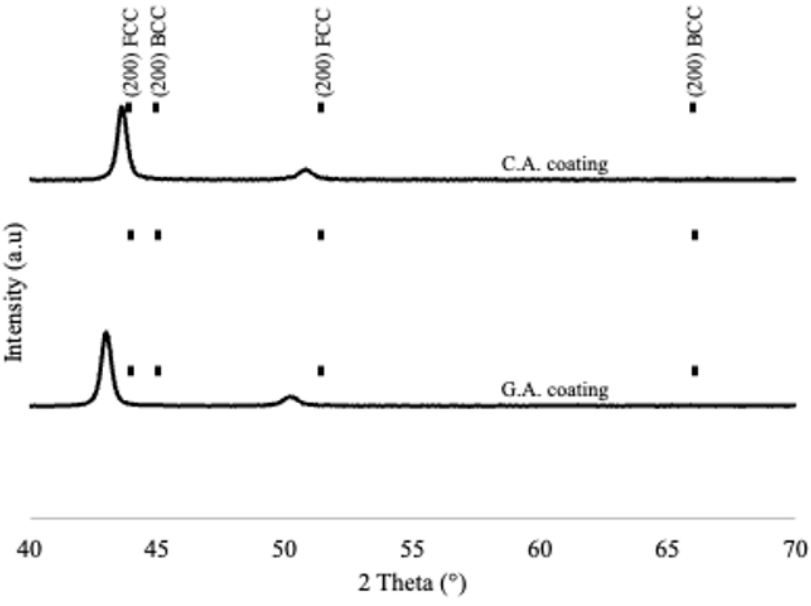
Figure 12. XRD spectra of coatings.